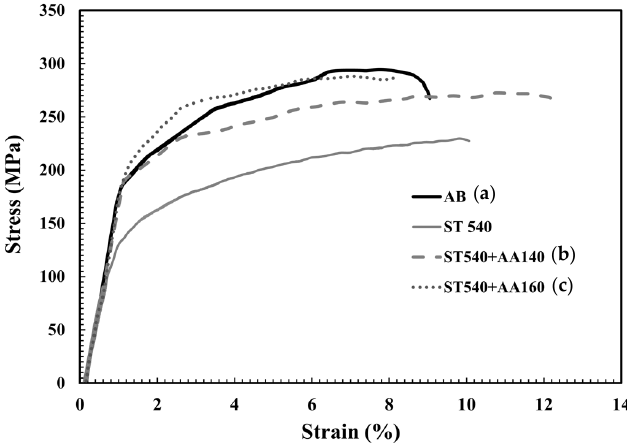
Figure 8. Stress–strain curves, YS, UTS and Elongation at break for ( a ) as-built ( b ) ST + AA at 140 ° C for 12 h ( c ) ST + AA at 160 ° C for 8 h. Table 2. Tensile Properties of AlSi10Mg Specimens.